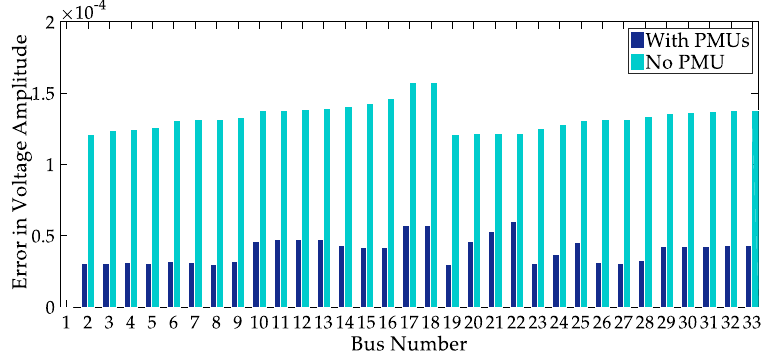
Figure 5. Comparison of error in voltage amplitude estimation.